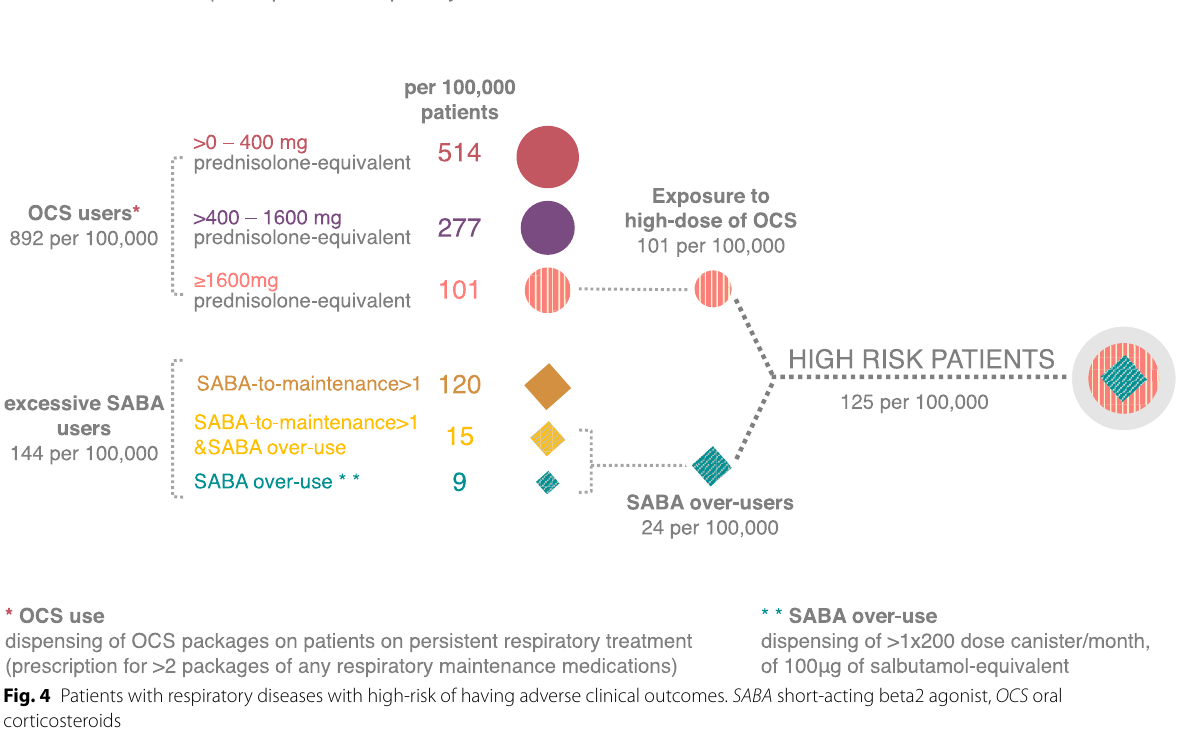
Fig. 4 Patients with respiratory diseases with high‑risk of having adverse clinical outcomes. SABA short‑acting beta2 agonist, OCS oral